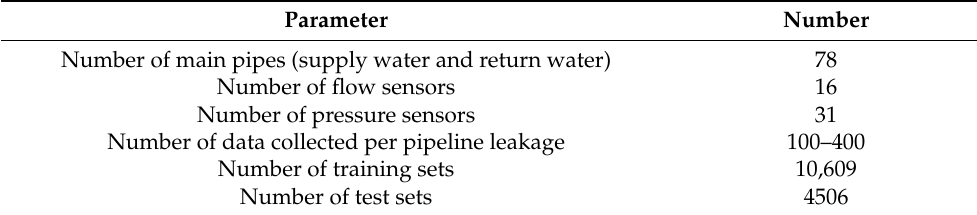
Table 2. Pipe network design information and data quantity.